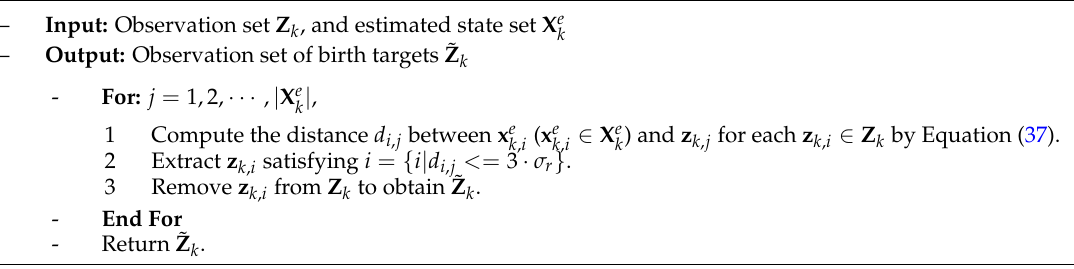
Table 1. Removing observations generated by the estimated